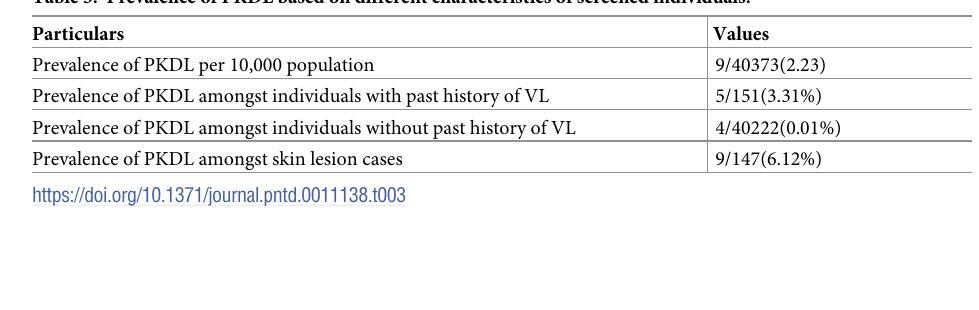
Table 3. Prevalence of PKDL based on different characteristics of screened